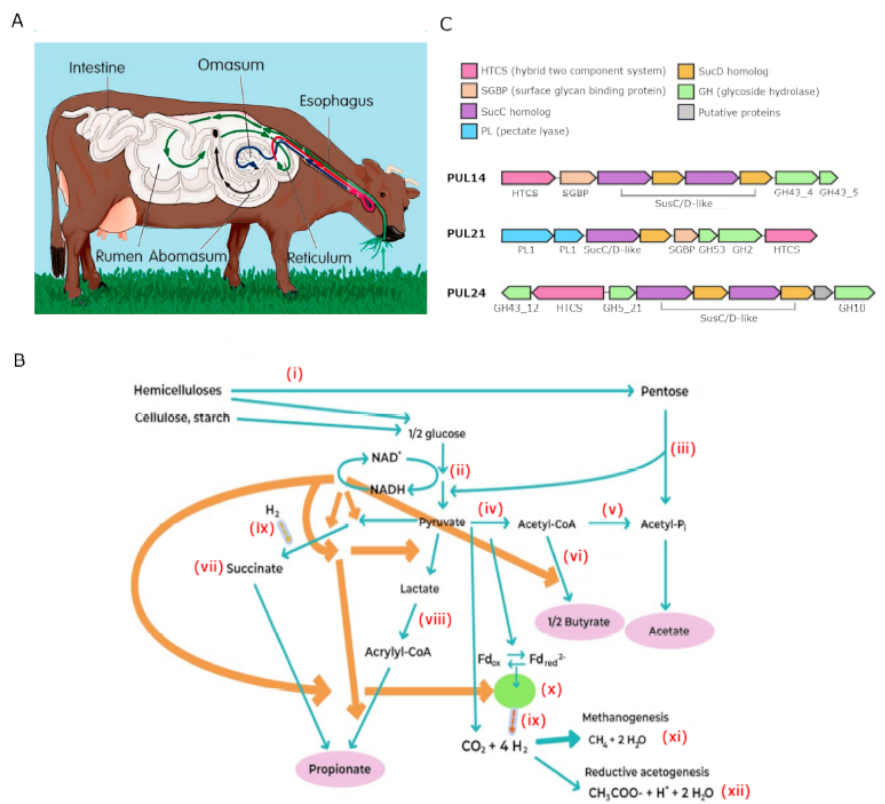
Figure 1. Ruminal carbohydrates fermentation. ( A ) Ruminants lack enzymes for digestion of cellulose contained in the cell wall of plant material. Therefore, digestion of carbohydrates starts with initial mastication and passage of feedstuff to the rumen (green arrow), where cellulolytic bacteria partially degrade plant cell walls. Semi-digested material flows then to the reticulum, which facili- tates regurgitation (red arrow) and rechewing of feed particles. Remasticated, finer feed particles are mobilized to the omasum (blue arrow). Finally, feedstuff passes to the abomasum (black arrow), which is considered the true stomach where an acidic pH facilitates digestion of microbial and plant proteins. ( B ) Simplified schematics of carbohydrate fermentation. ( i ) Breakdown of polysaccharides to monosaccharides; ( ii ) A glucose molecule is oxidized into two molecules of pyruvate with con- comitant reduction of NAD + to NADH; ( iii ) Pentose metabolism through the pentose cycle and transketolase cleavage; ( iv ) Pyruvate oxidative decarboxylation with production of CO 2 , reduced ferredoxin and acetyl-CoA. An alternative reaction releases formate instead CO 2 and reduced ferre- doxin; ( v ) Acetate production; ( vi ) Butyrate production; ( vii ) Propionate production via the succin- ate pathway; ( viii ) Propionate production via acrylate pathway. ( ix ) Interspecies hydrogen trans- ference; ( x ) Production of molecular hydrogen through electron confurcation; ( xi ) Hydrogen- otrophic methanogenesis; ( xii ) Reductive acetogenesis; which is a smaller H 2 sink than ( xi ). Not all reactants or products are shown. Figure 1B was modified from [85]. Orange thick arrows indicate points where the redox couple (NAD+ and NADH) promote chemical reactions. ( C ) Genetic archi- tectures of some PUL loci in P. copri , the central SusC/D proteins, the hybrid two component system (HTCS), glycoside hydrolases (GH), pectate lyases (PL) and surface glycan binding proteins (SGBP) are depicted. Figure 1C was modified from [86].